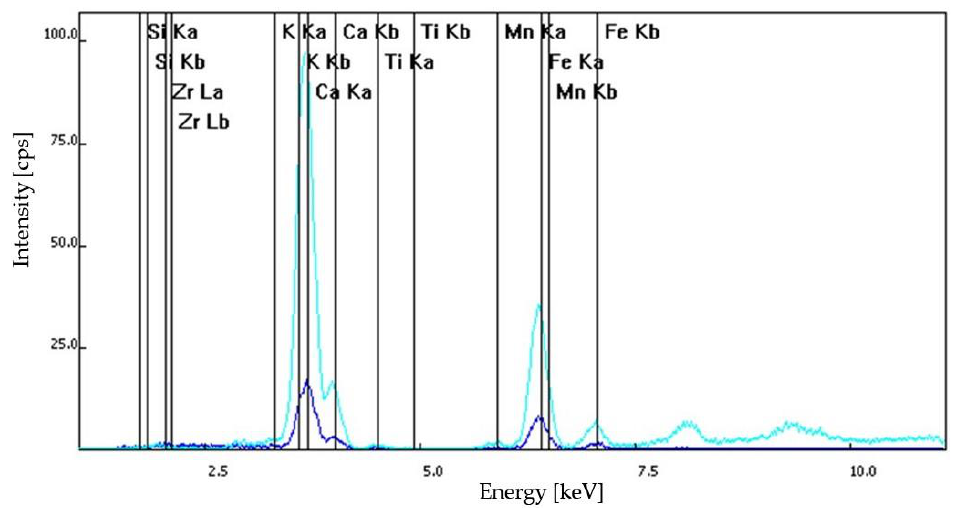
Figure 10. S3 sample series: XRF spectra.